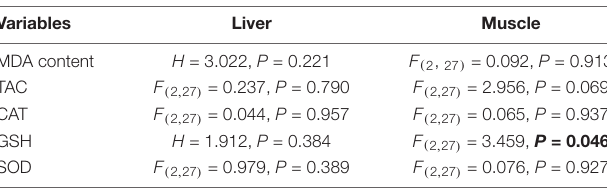
TABLE 2 | Statistical results of the effects of heat wave on oxidative stress indices in liver and muscle of Mauremys mutica. Variables